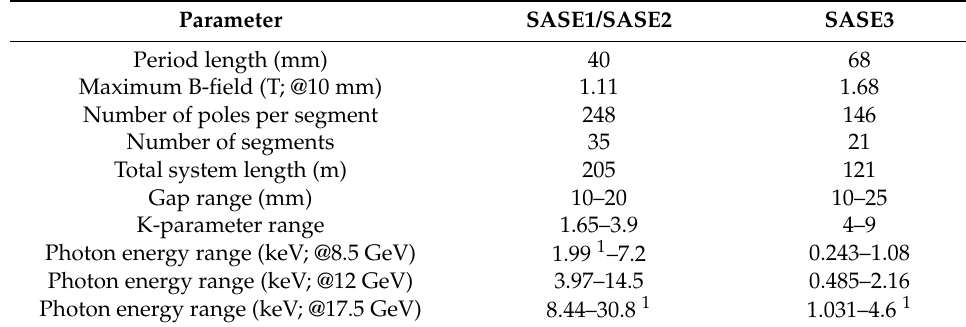
Table 2. FEL undulator source parameters [24].